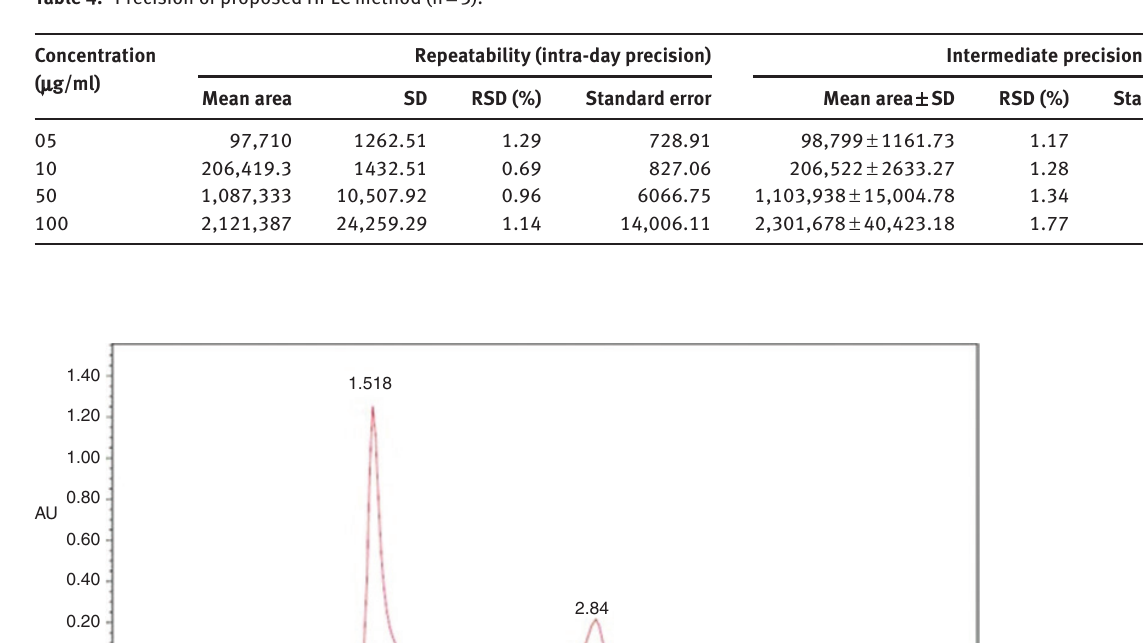
Table 4: Precision of proposed HPLC method (n = 3).